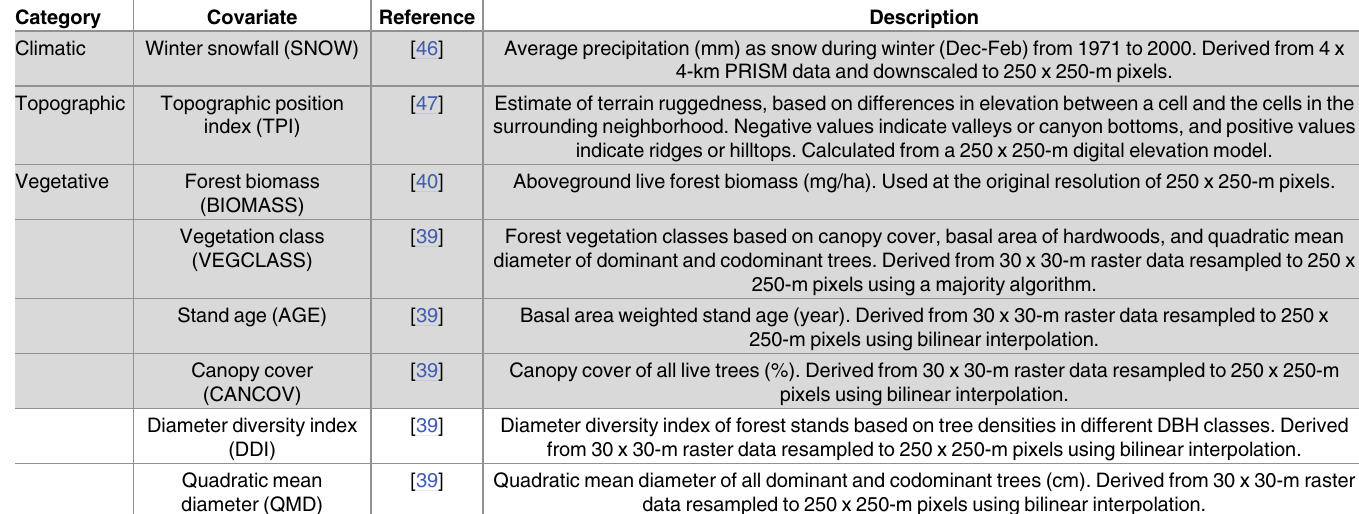
Table 2. Environmental covariates considered for generating species distribution models for the fisher in the Pacific States using Maxent. The 6 covariatesselectedfor Maxent modeling are shaded